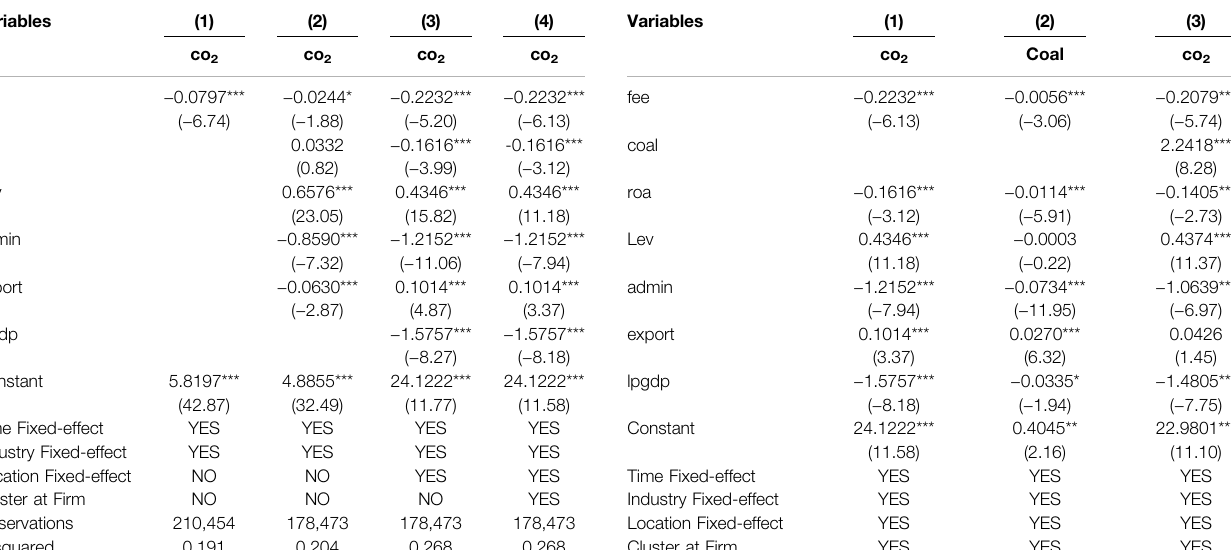
TABLE 4 | Full sample regression results. TABLE 5 | mediating effect analysis.